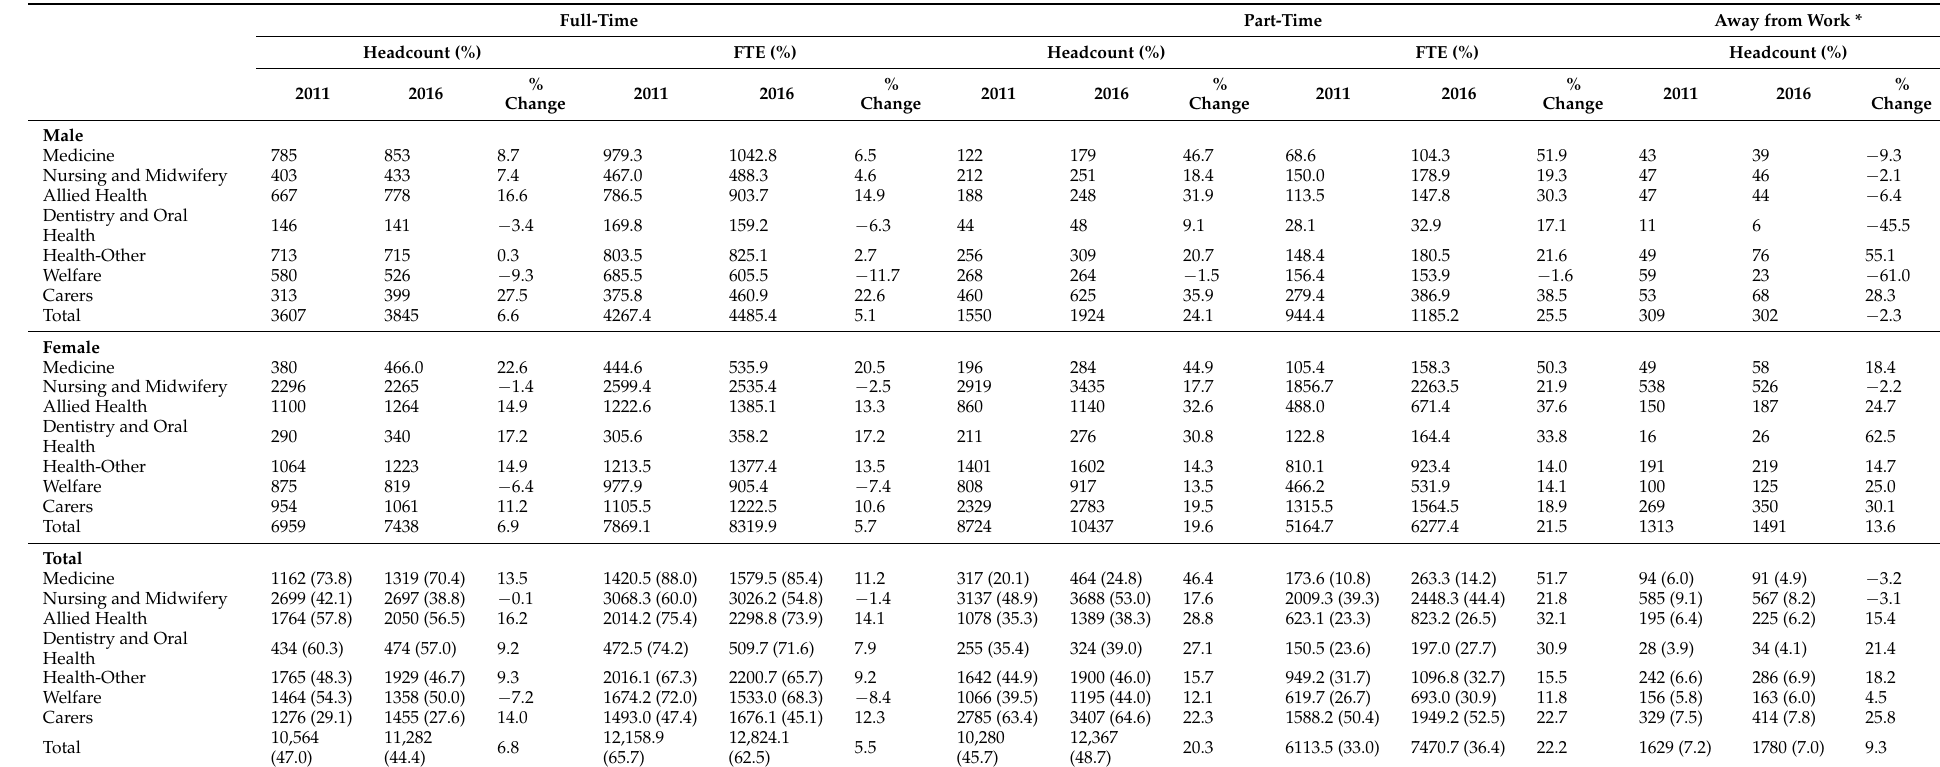
Table 5. Changes in employment participation of the Tasmania health, welfare and care workforce between 2011 and